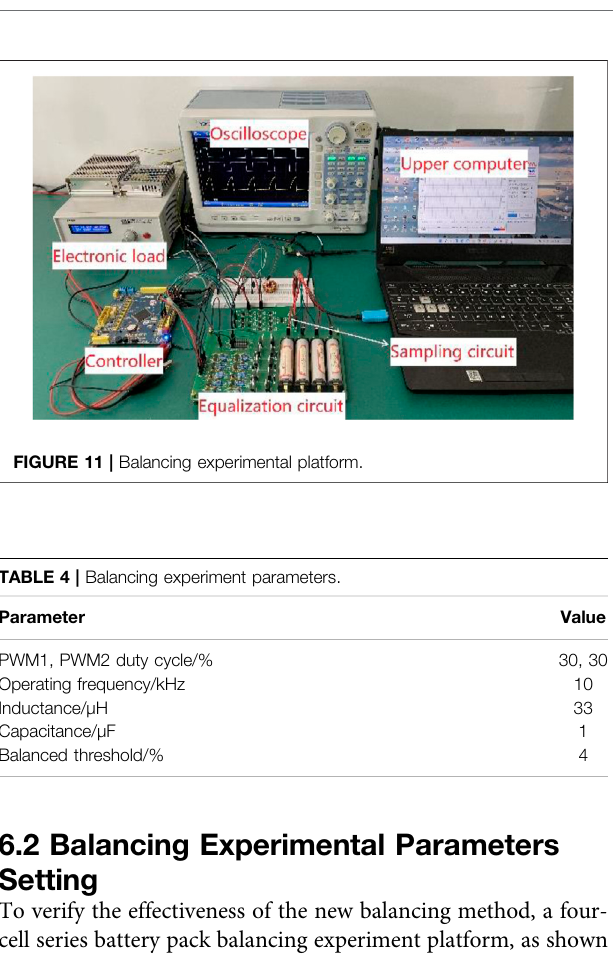
FIGURE 12 | The experimental waveforms where the B 2 SOC is the highestandtheB 3 SOCisthelowest. (A) PWM1,PWM2,andinductorcurrent waveforms. (B) Voltage waveforms of each